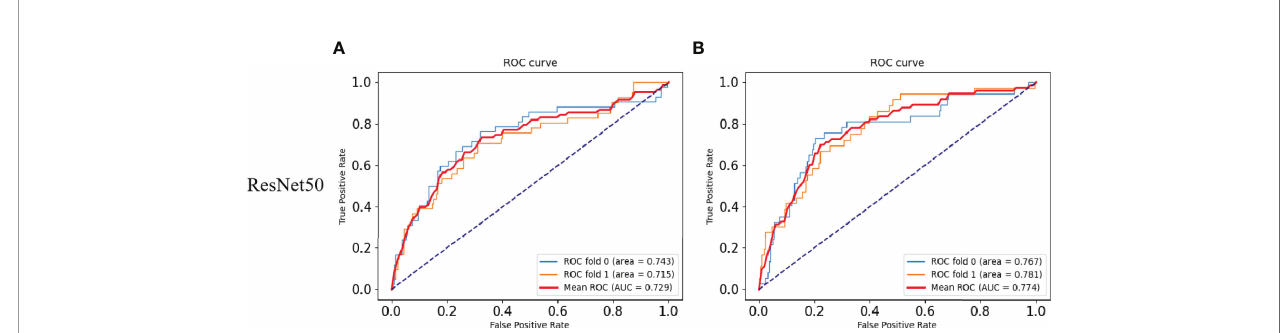
FIGURE 2 | Results of the TMB prediction model. (A) ROC plot of the ResNet50 model with a TMB cutoff of 10 under 2-fold cross-validation. (B) ROC plot of the ResNet50 model with a TMB cutoff of 20 under 2-fold cross-validation.